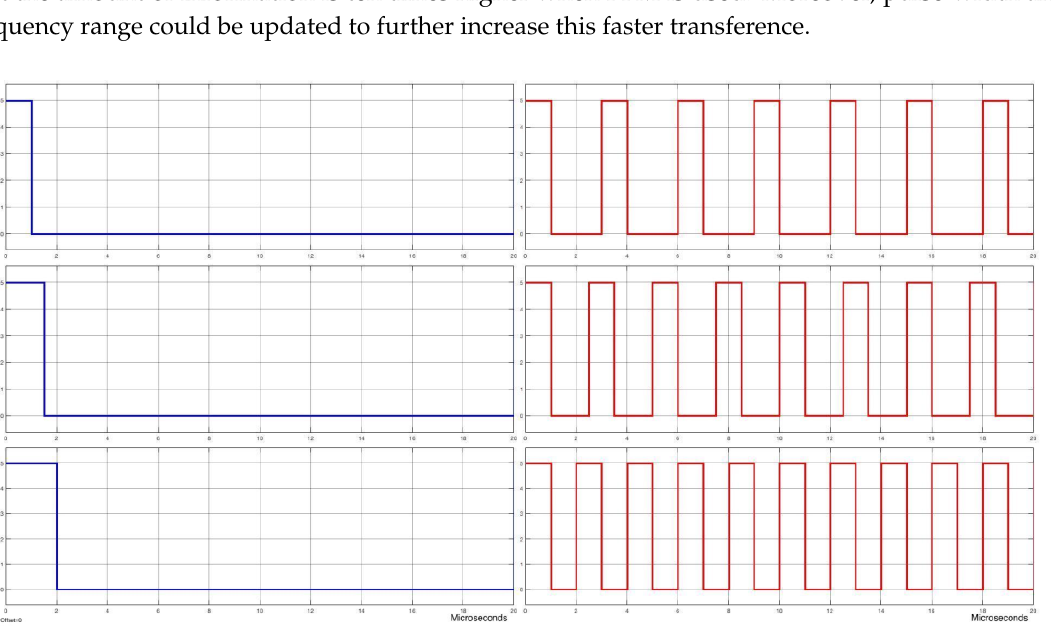
Figure 12. Pulse comparison between PWM and PFM signals at the same range time: ( Left ) PWM; and ( Right ) PFM.